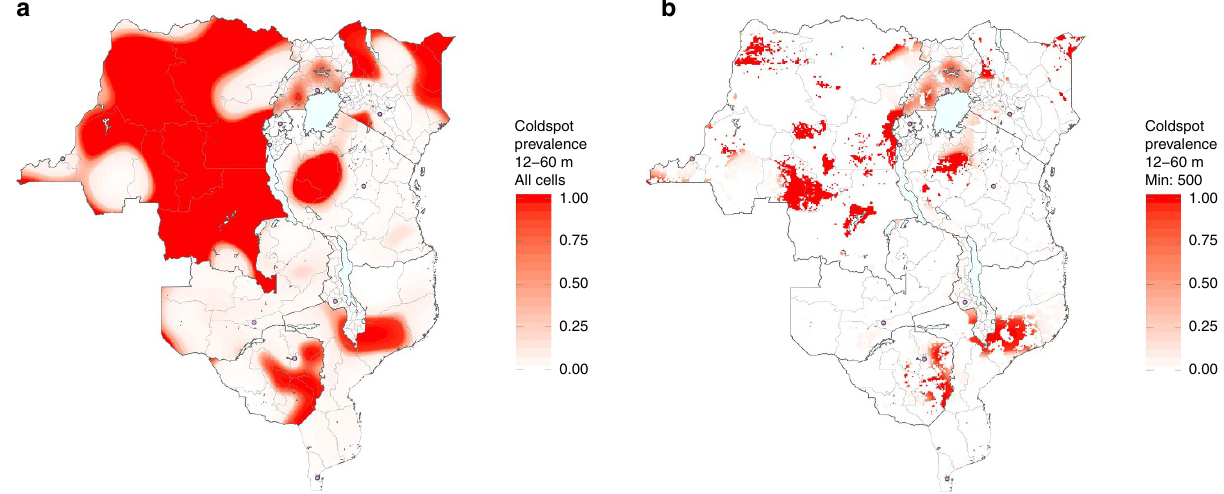
Figure 3 | Vaccination coldspots and population density. Estimated proportion of monthly age cohorts that each 10km by 10km grid cell exists as a coldspot of routine and national SIA measles vaccination for children between 12–60 months of age (total of 49 monthly age cohorts), showing ( a ) all grid cells (long-term coldspots) and ( b ) only grid cells with at least 500 children under 60 months of age (long-term, high-density coldspots). Capital cities are shown as pink circles. The first sub-national political boundaries are shown in light